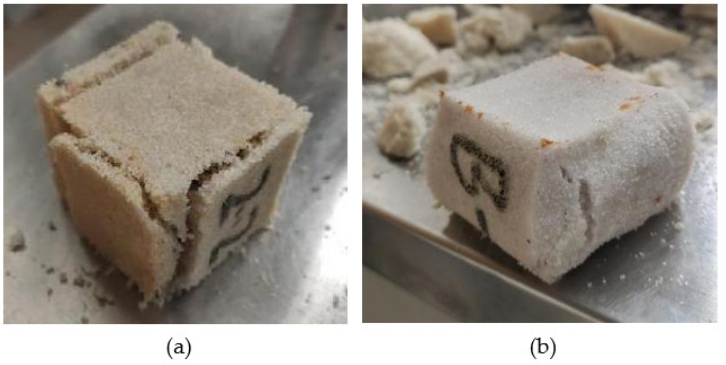
Figure 4. Chemical grouted sands performance change curve: ( a ) variation of compressive strength; ( b ) variation of permeability coefficient.